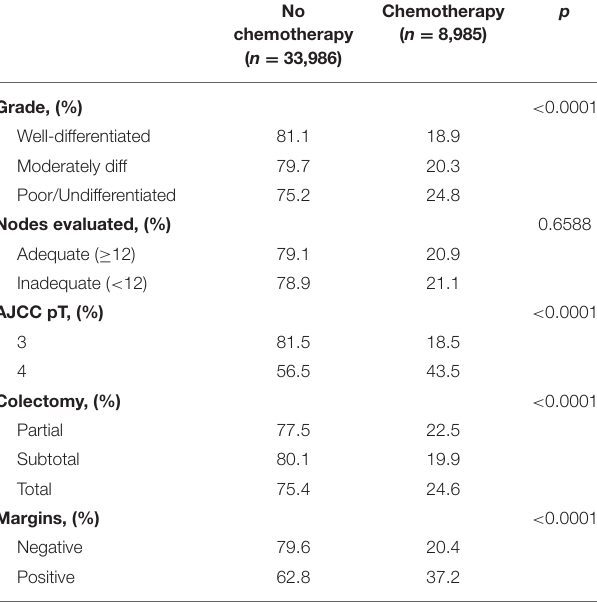
TABLE 1 | Baseline patient characteristics, stratified according to receipt of adjuvant